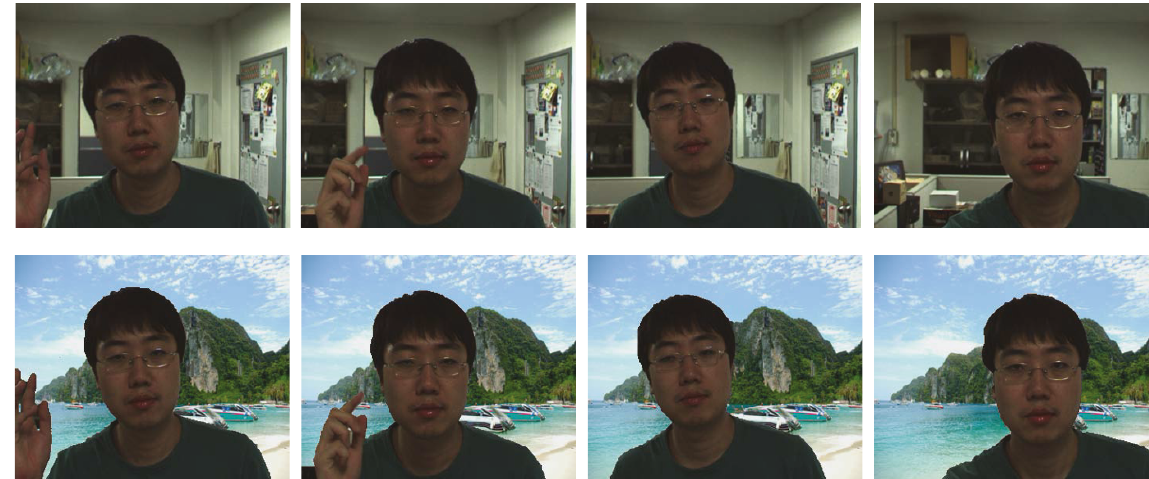
Figure 14: Background substitution. The 1st and 3rd column shows original frames, and the 2nd and 4th columns show the synthesized frames with the replaced background. The proposed algorithm I is used for the segmentation.